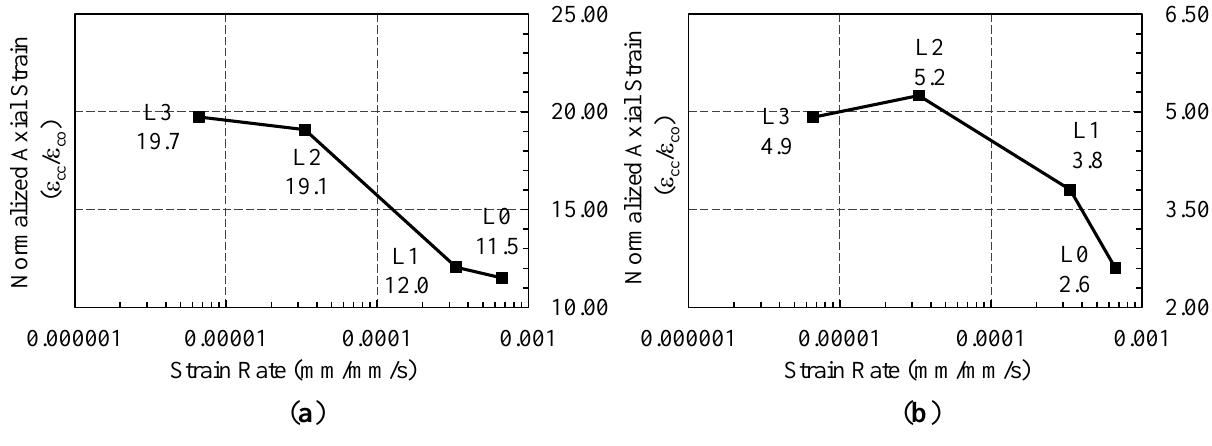
Figure 6. The variation of lateral strains at failure with strain rate ( a ) Low strength concrete. ( b ) Medium strength